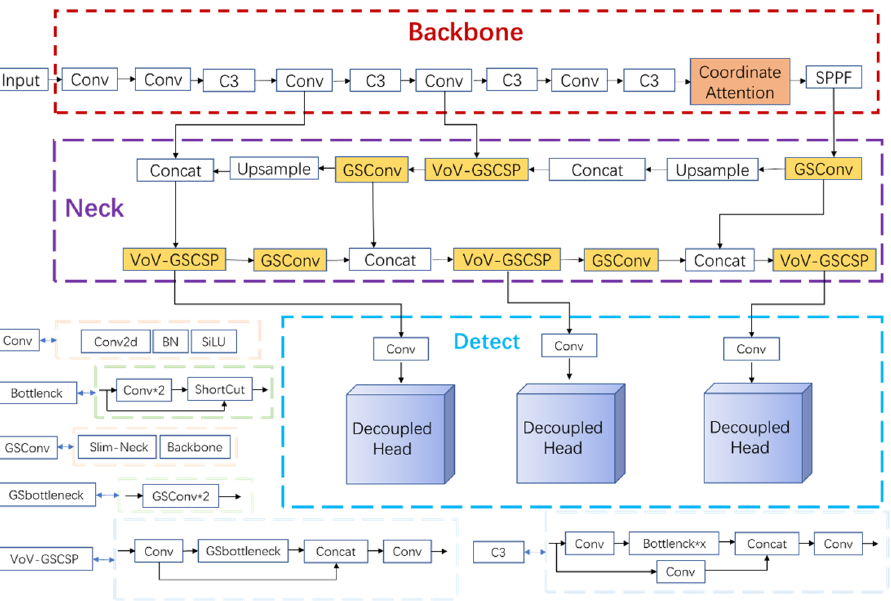
Figure 5. Network structure of production line equipment identification and localization method based on improved YOLOv5s model.